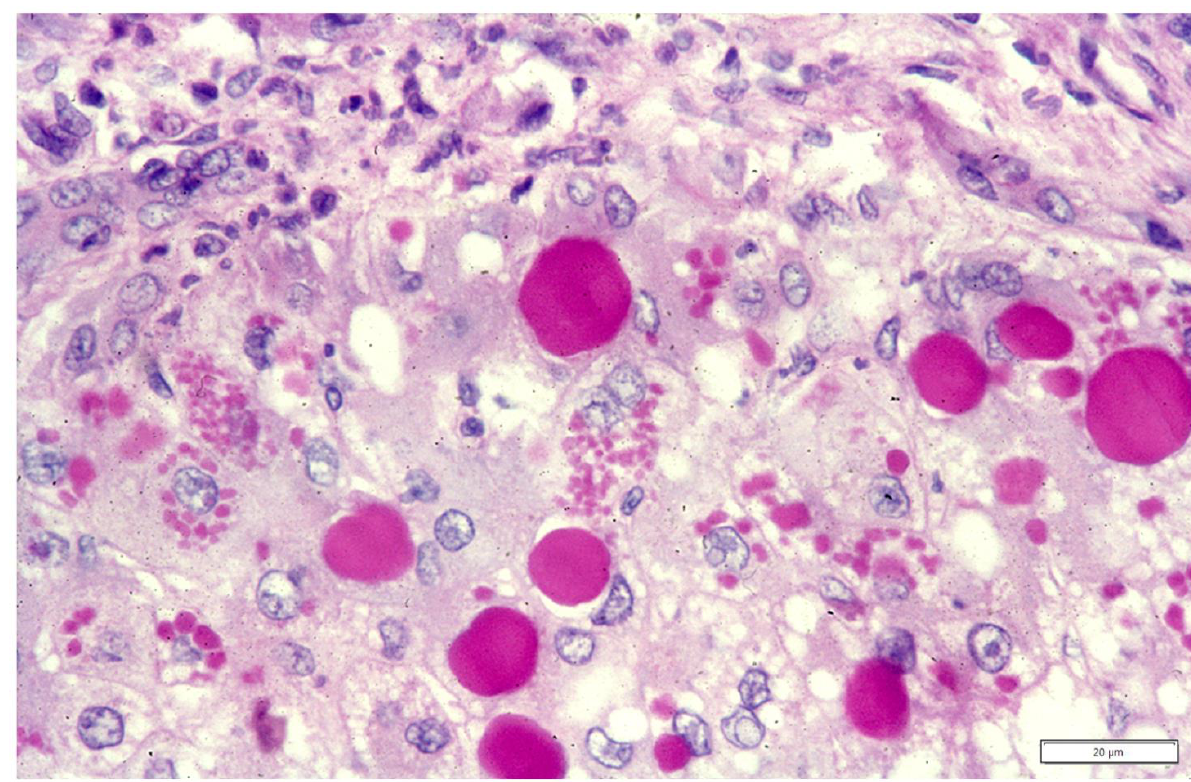
Figure 12. Pi ZZ liver. The cytoplasm of the hepatocytes is engulfed by Z AAT storage. Dilated cisternae of the RER contain AAT in the form of amorphous fluffy material and coalesce after disruptor of membranes and occupy the entire volume of the cell (thin arrow). Excess mitochondria (thick arrow) and glycogen rosettes (dot) indicate the periportal location of the cells (EM × 9200).